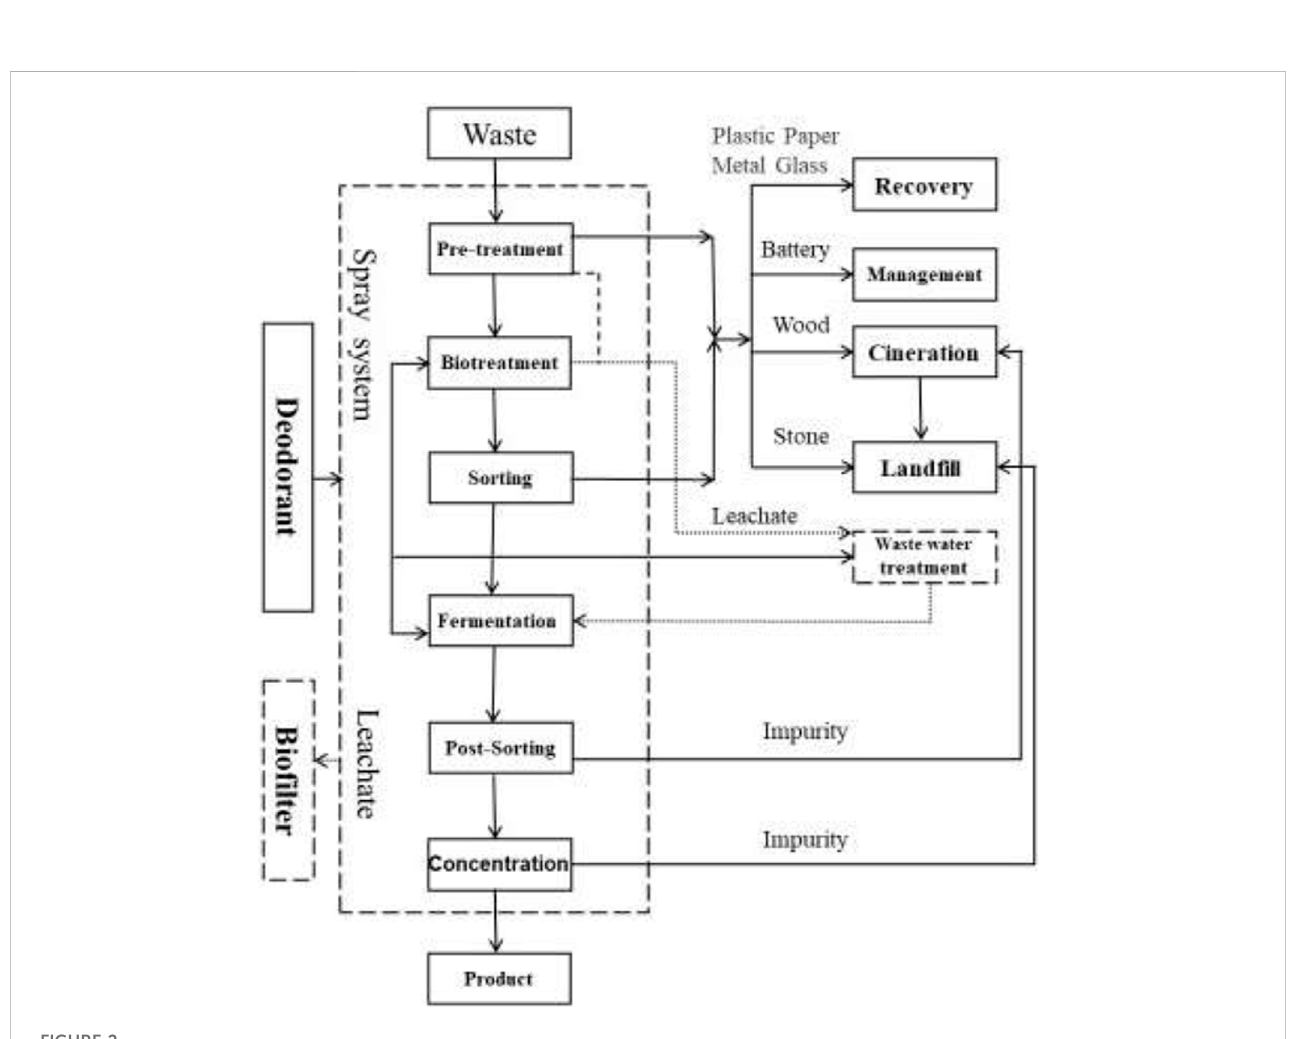
FIGURE 2 Schematic diagram of the high-pressure deodorization